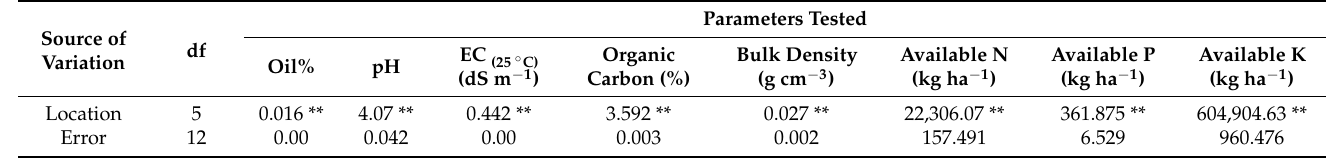
Table 3. Analysis of variance for determining the effect of location on oil concentration in different populations of V. jatamansi and on soil properties (values of mean squares are